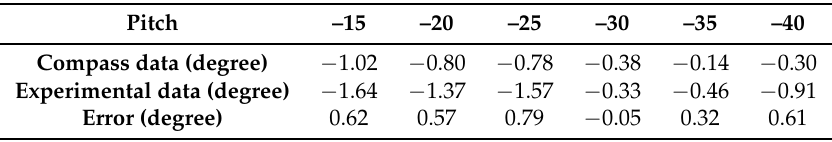
Table 4. Comparison of yaw angles with pitch angles changed from − 15 ◦ to − 40 ◦